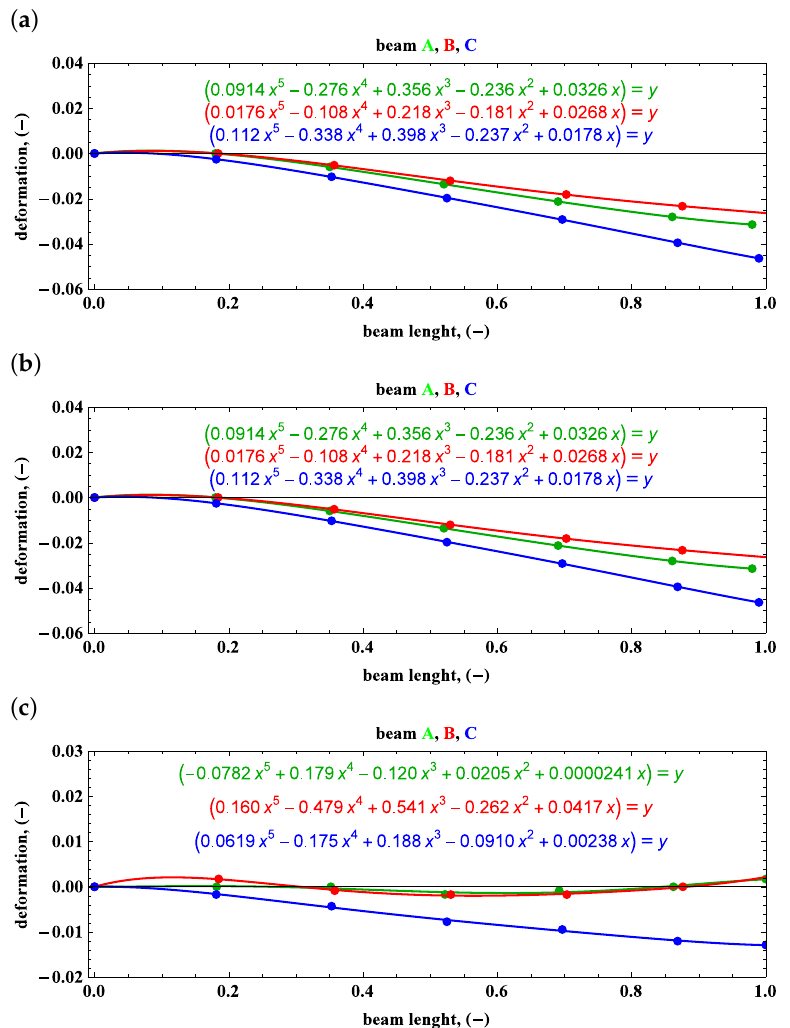
Figure 15. Side view—beam deformations and their description by polynomials: ( a ) preset angle 0 ◦ and angular speed 50 rpm, ( b ) preset angle 0 ◦ and angular speed 100 rpm, ( c ) preset angle 0 ◦ and angular speed 150